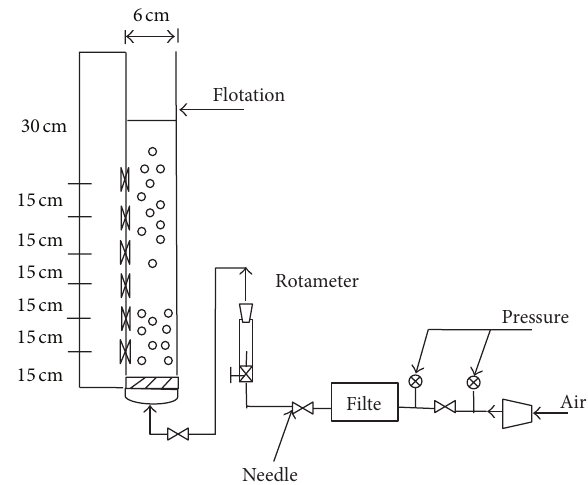
Figure 1: Schematic diagram of the experimental